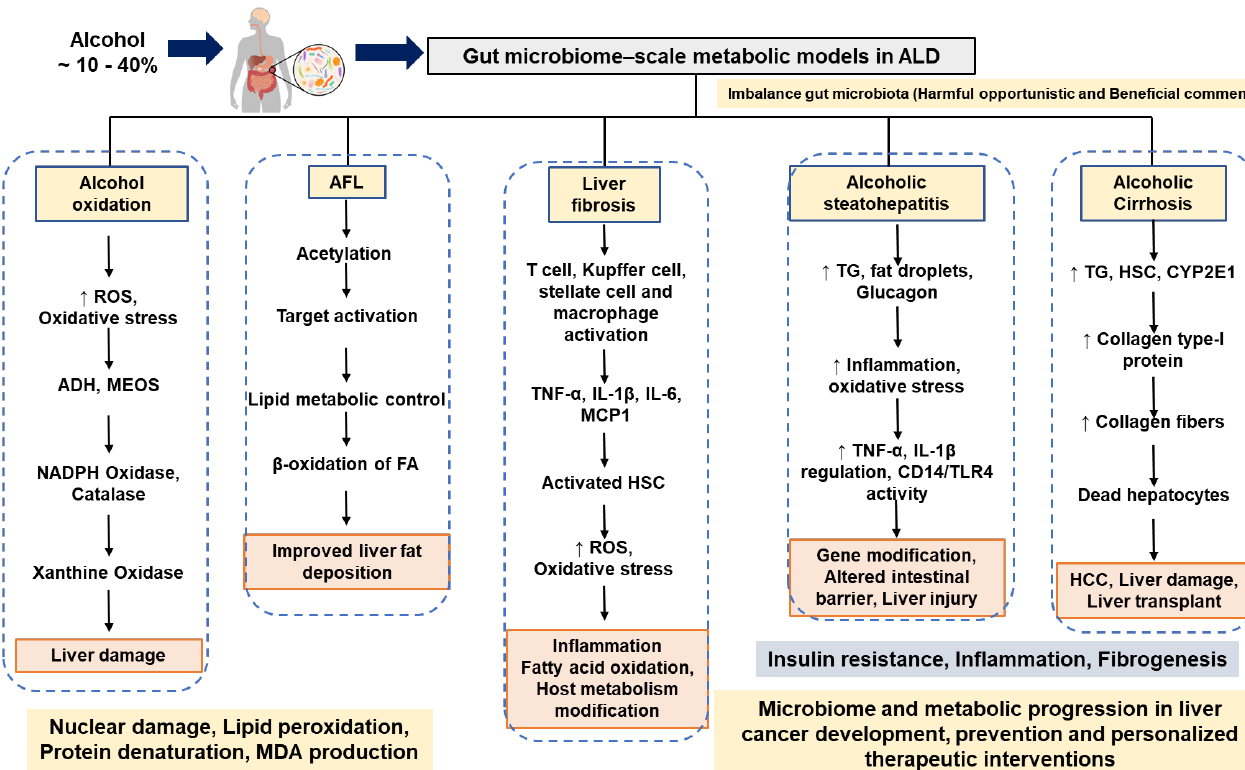
Figure 1. Summary of possible mechanisms and discussions of gut microbiome-derived metabolic oxidation, inflammation, and inhibition, which could be involved in the development of ALD. The possible metabolic influence of liver dysbiosis on ALD. Abbreviations: ALD, alcoholic liver disease; AFL, alcoholic fatty liver; TG, triglyceride; TNF- α, Tumor necrosis factor - α ; IL, interleukin; ROS, reactive oxygen species; HS, hepatic stellate cell; NADPH, Nicotinamide adenine dinucleotide phos- phate; ADH, alcohol dehydrogenase; TLR, Toll-like receptor.